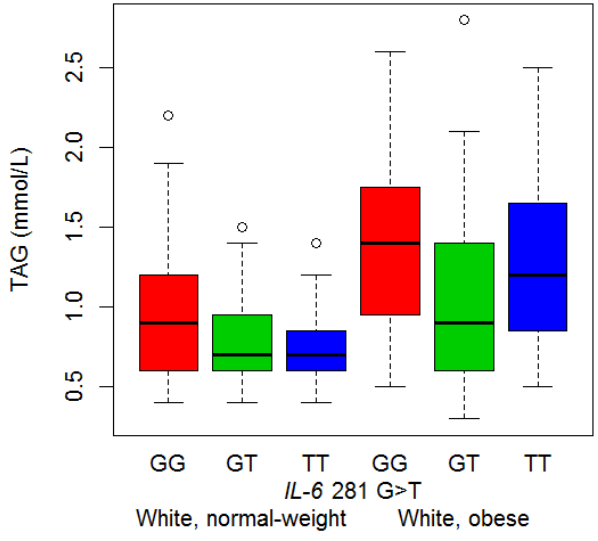
Figure 3. Association of IL-6 IVS3 +281 G>T polymorphism with triglyceride